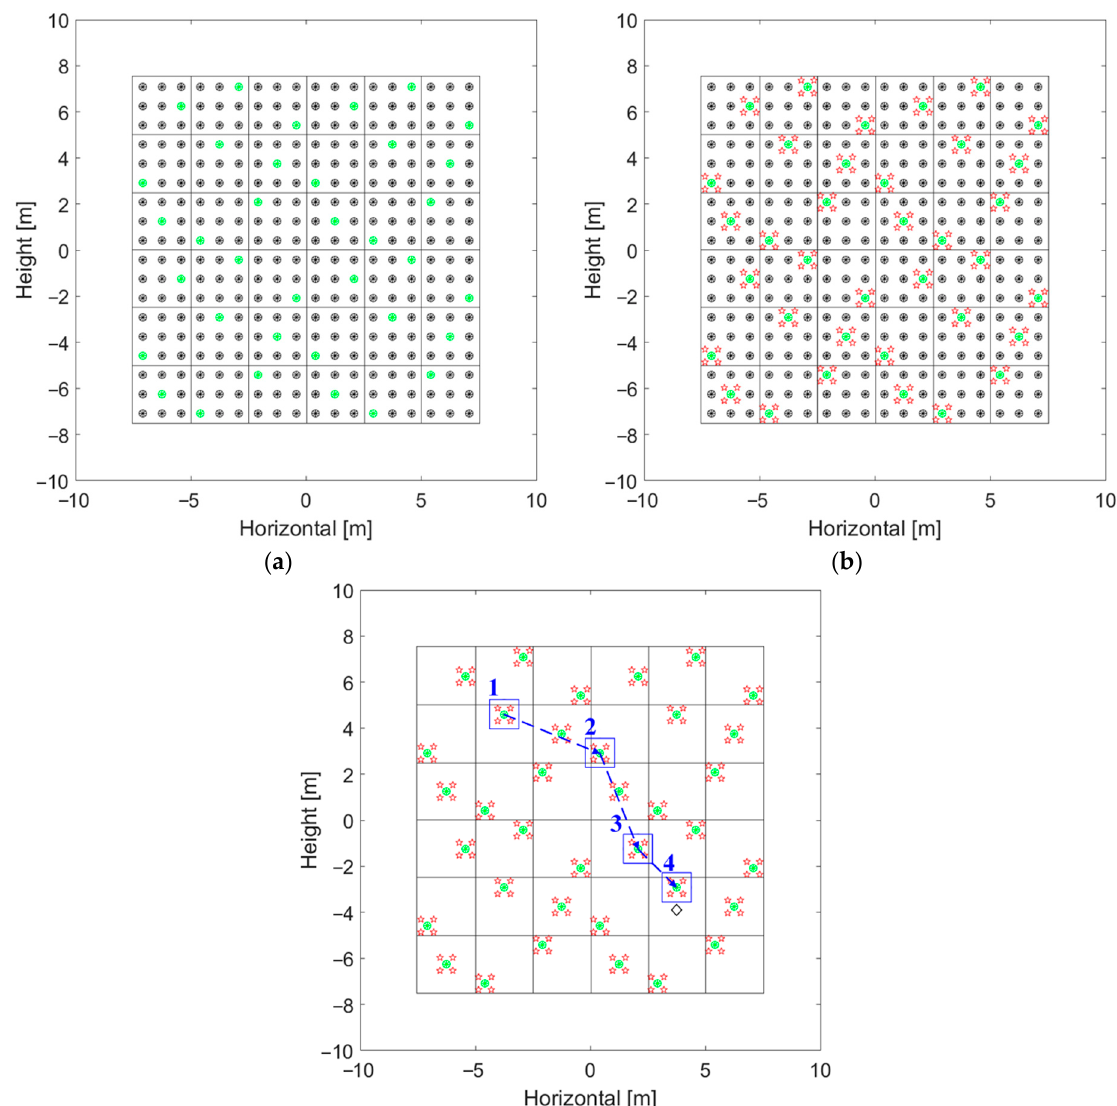
Figure 6. The schematic of searching a trapped person along a searching path. ( a ) The available observation points in the 2D observation aperture; ( b ) the wireless-netted radars are deployed around the observation point; ( c ) the vital sign searching path.